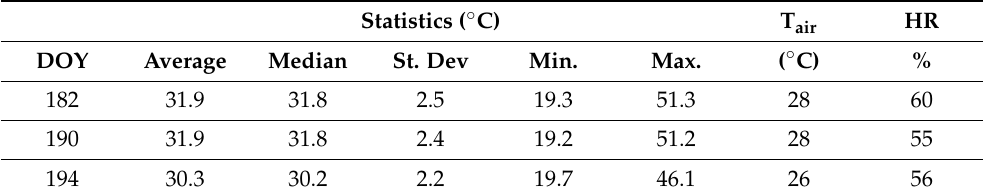
Table 1. Statistics (average, median and standard deviation) of temperature taken with an aerial camera, relative humidity (HR %) and air temperature (T air ◦ C) on the three data collection days of the year (DOY).